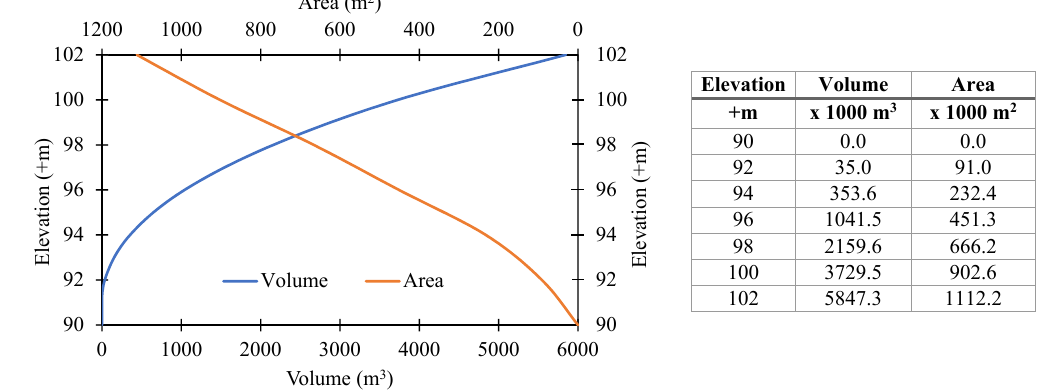
Figure 2. Reservoir characteristics of Ketro